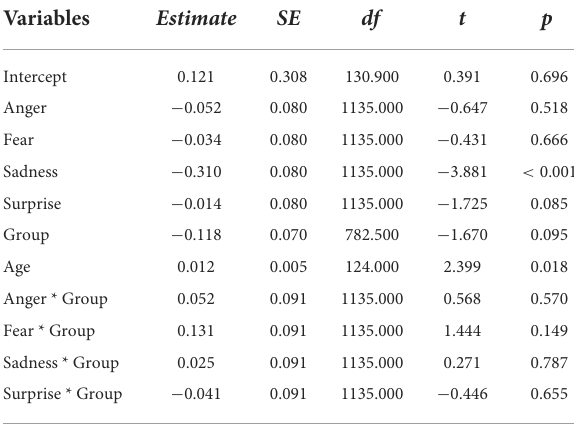
TABLE 1 Child faces task: association with pandemic-related changes in social